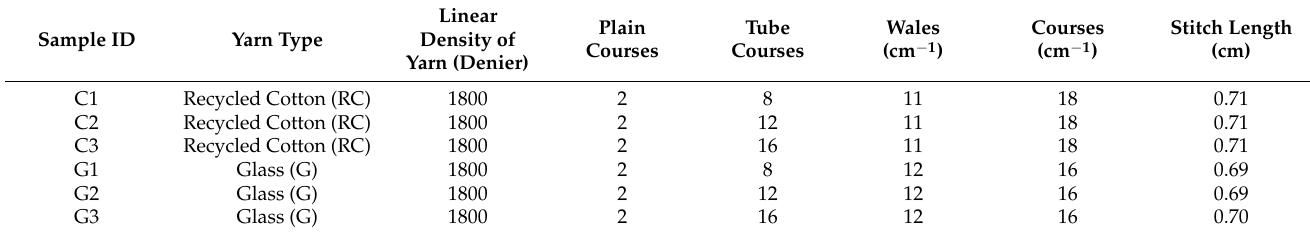
Table 1. Knitted fabric